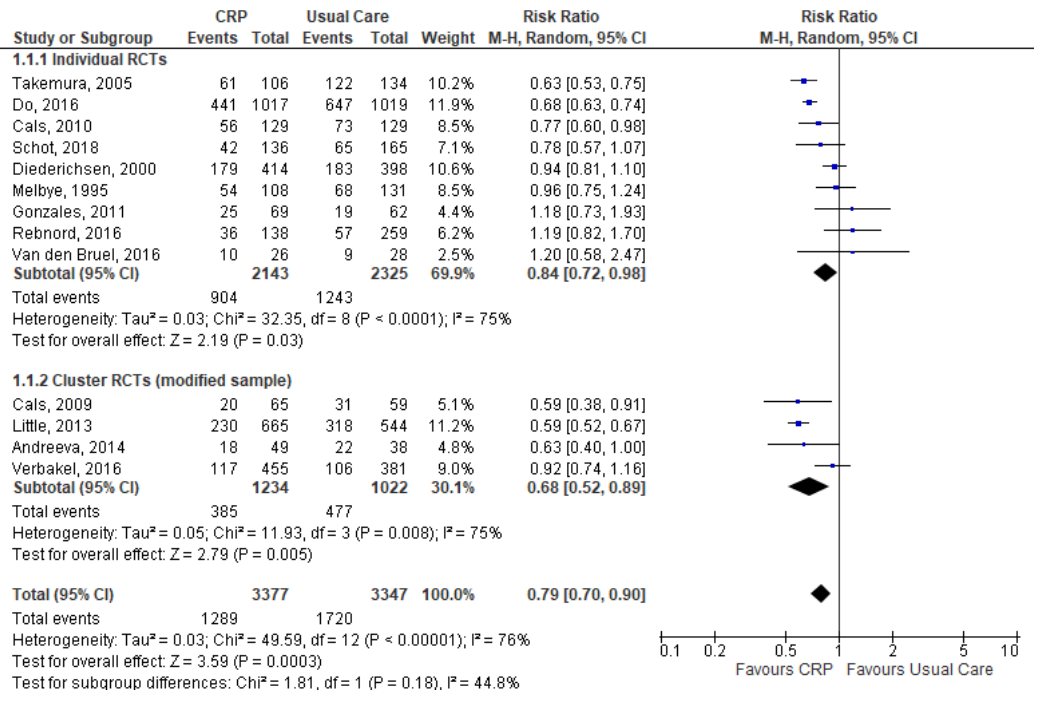
Figure 2. Comparison: CRP-POCT versus usual care. Overall antibiotic prescribing at index consultations. CRP, C-Reactive Protein Point Of Care Test; RCTs, Randomised Controlled Trials; M-H, Mantel-Haenszel; CI, Confidence Interval; df, degrees of freedom; I 2 , heterogeneity between trials.